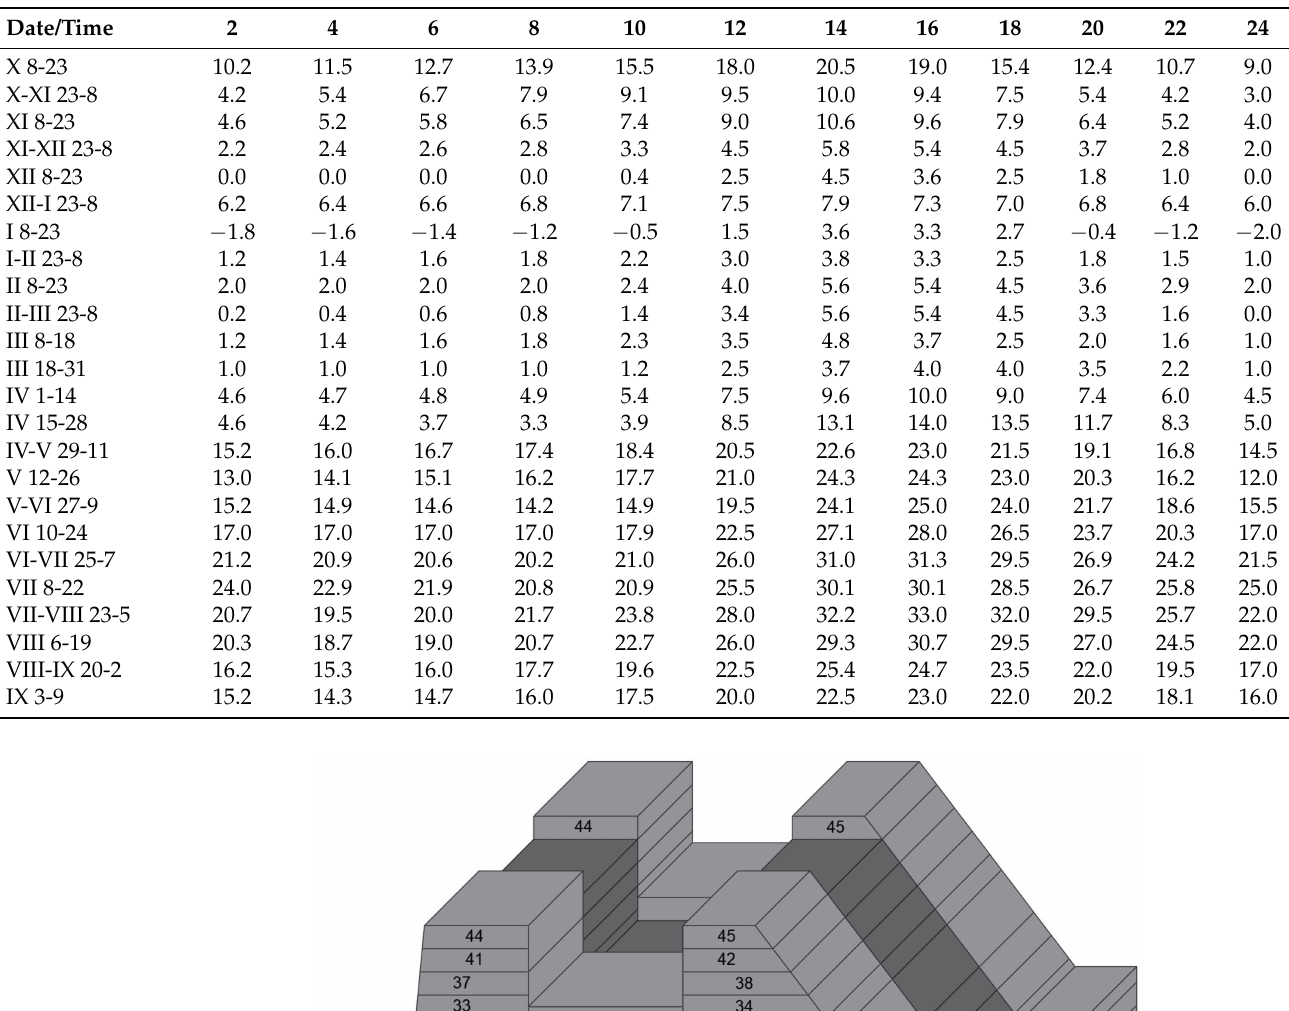
Table 1. Measured ambient temperatures T a [ ◦ C].